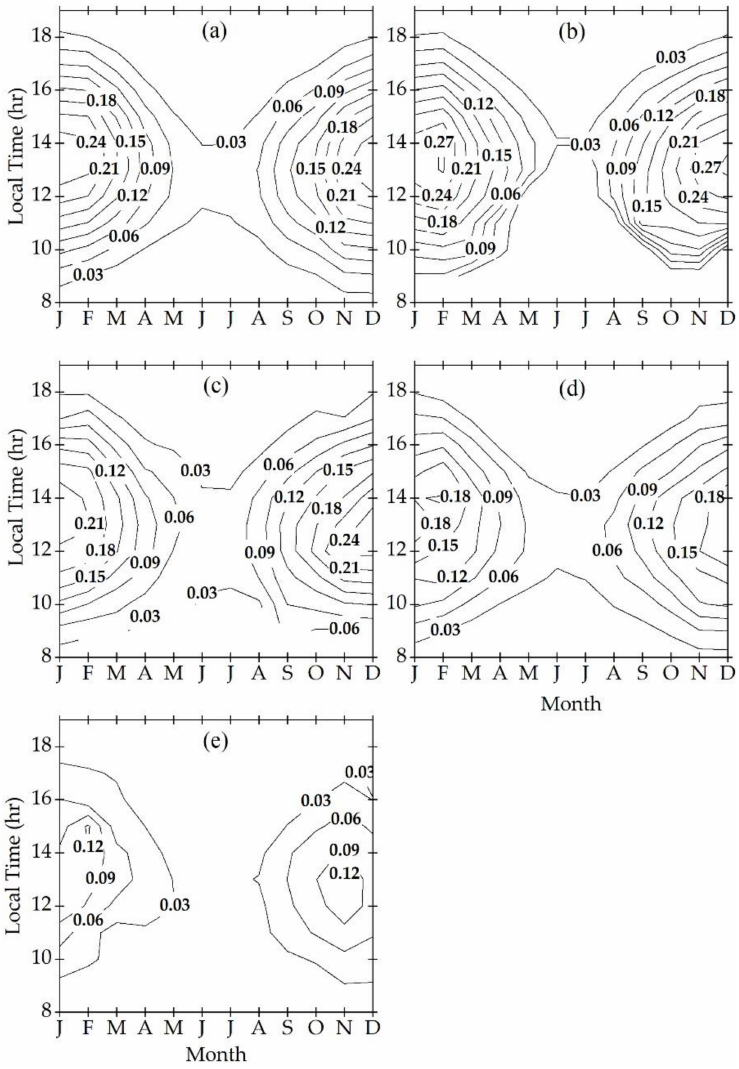
Figure 3. Contour plot of the monthly average hourly values of UVER for ( a ) all-sky, ( b ) clear, ( c ) par- tially clear, ( d ) partially cloudy, and ( e ) cloudy conditions observed during 2015–2019 in